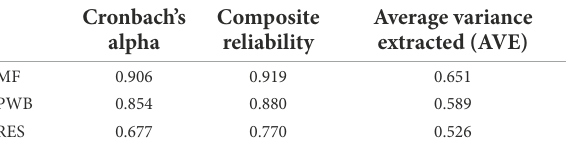
TABLE 1 Cronbach’s alpha, composite reliability, and AVE of the measures.